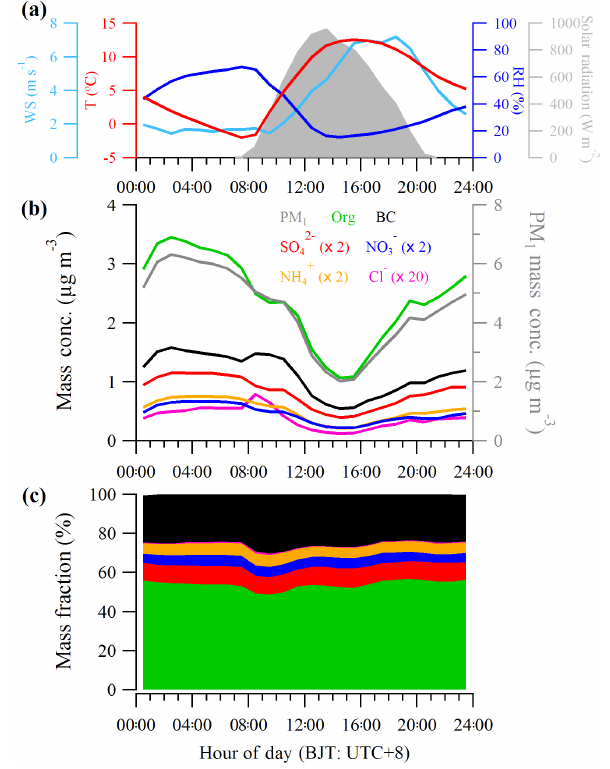
Figure 5. The diurnal cycles of (a) meteorological parameters (tem- perature, RH, wind speed, and solar radiation), (b) mass concentra- tions and (c) mass contributions of PM 1 chemical species for the entire